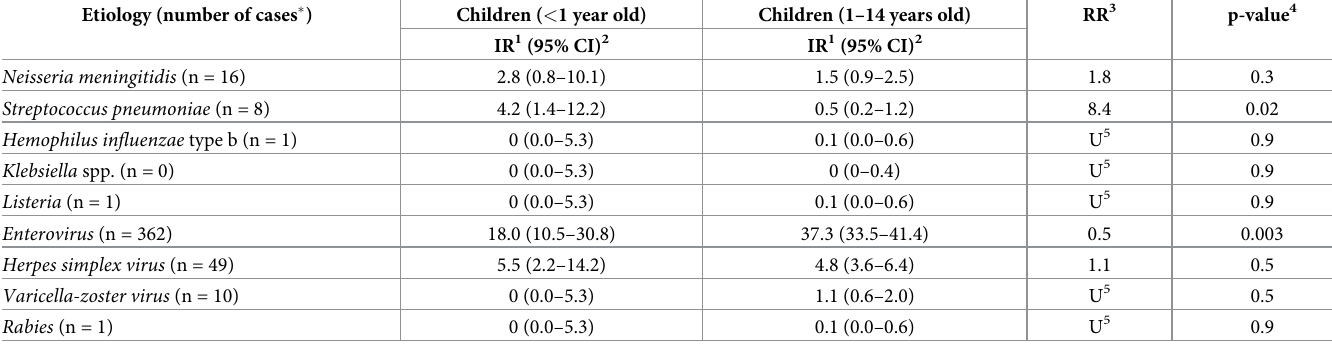
Table 2. Incidence rates of encephalitis/meningitis per 100,000 population by etiology in children < 1 year old and (1–14) years